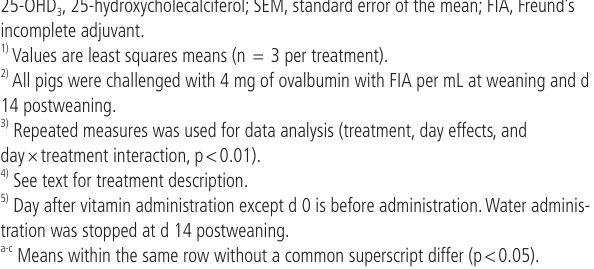
concentration changes of weaning pigs 3